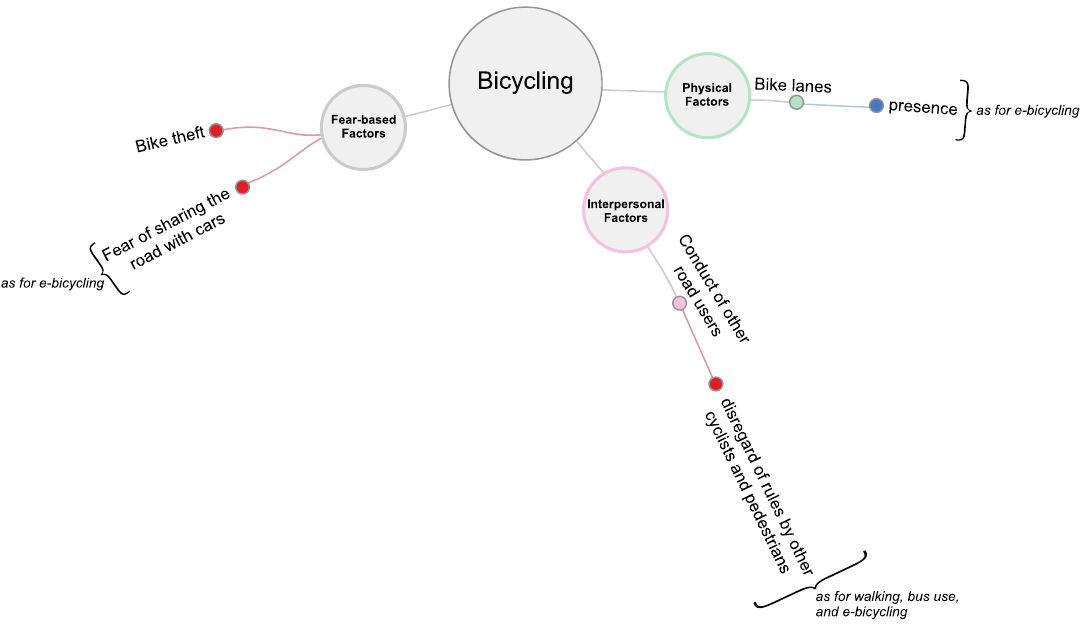
Figure A4. Radial dendrogram depicting the influences on older people’s bicycling, as derived from 1 article.